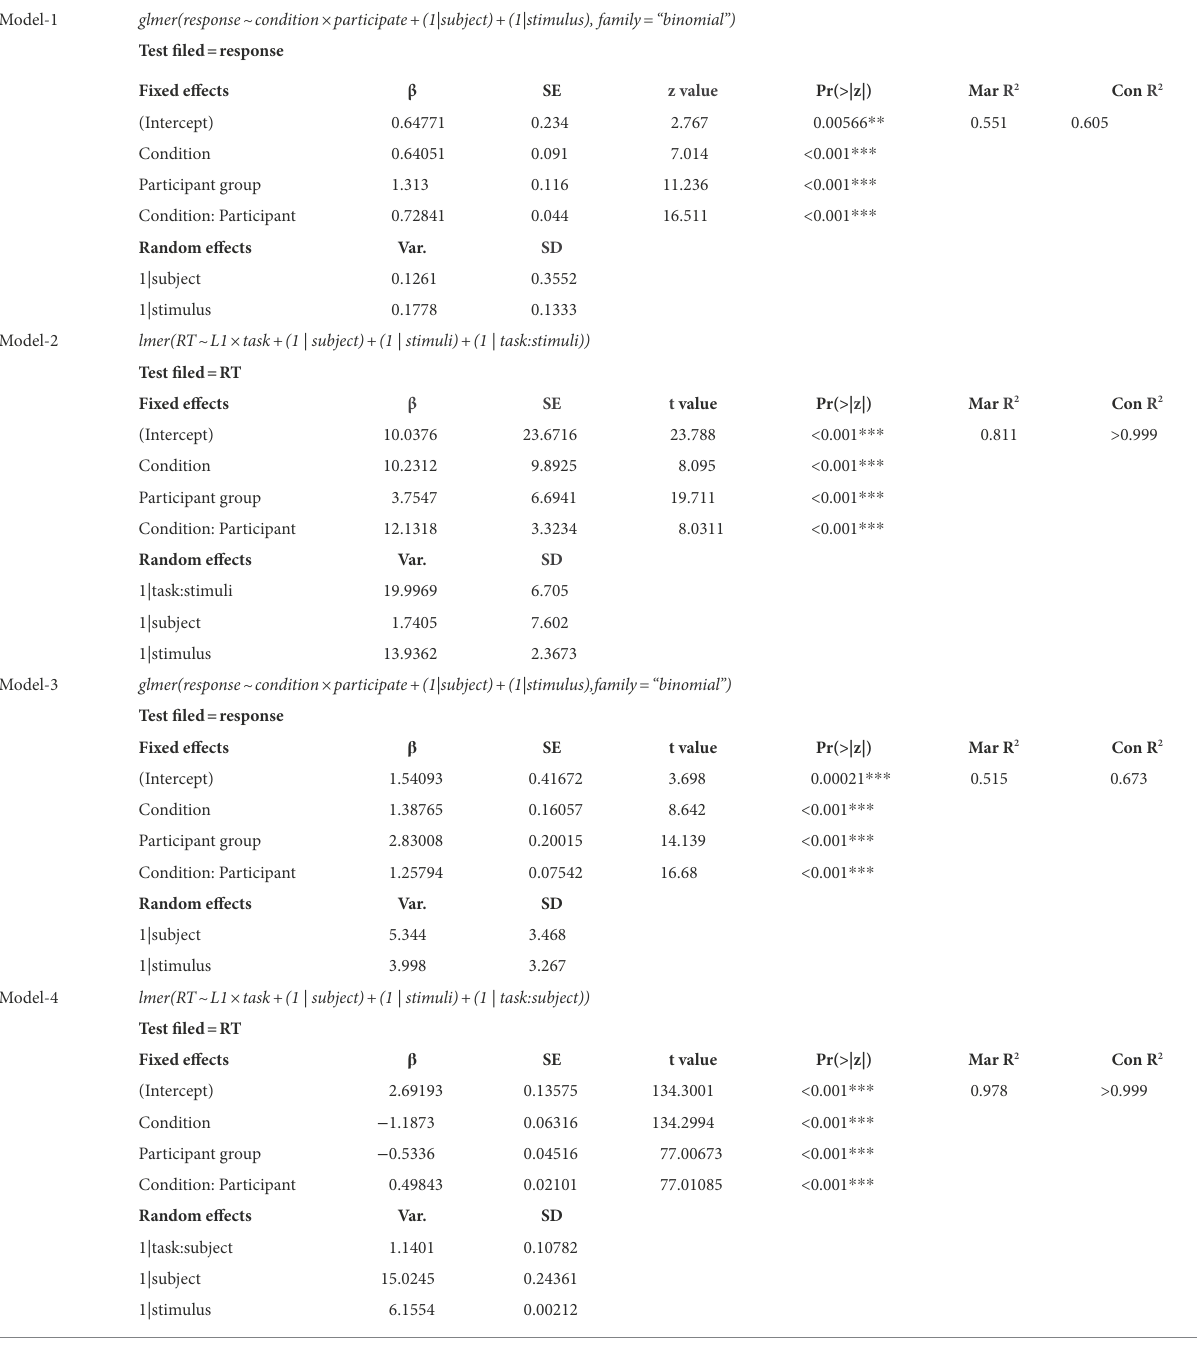
TABLE 3 The results of logistic and linear mixed-effect models for responses and RT.